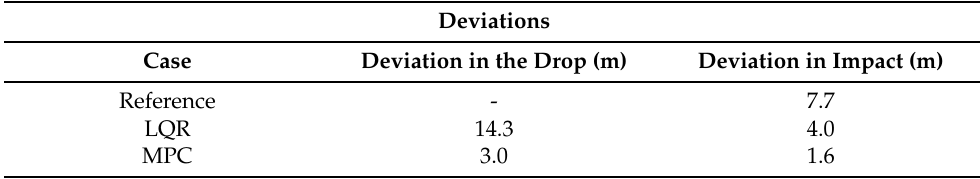
Table 1. Deviations in the release (from reference case) and in the impact of the bombs.